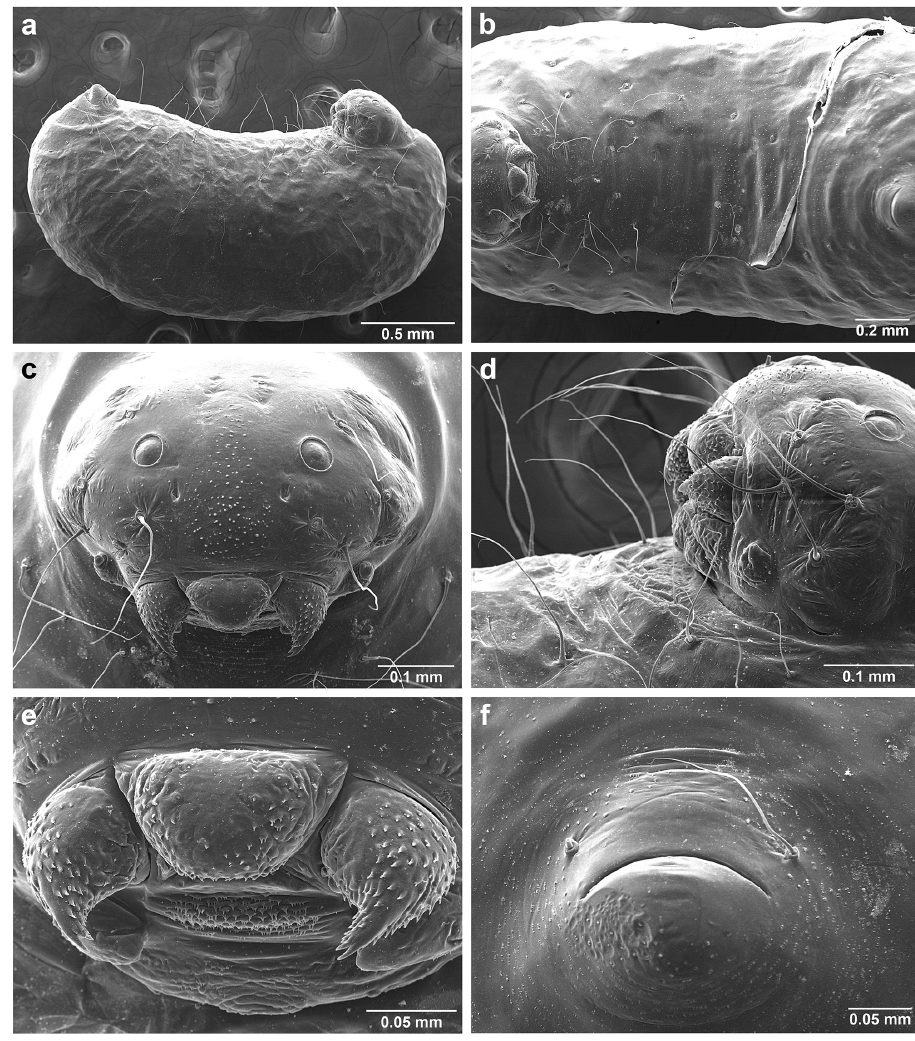
Figure 20. S. amabilis larva (USNMENT01126216), SEM images. a Lateral view b ventral view c head, frontodorsal view d head, lateral view e mouthparts; f anal